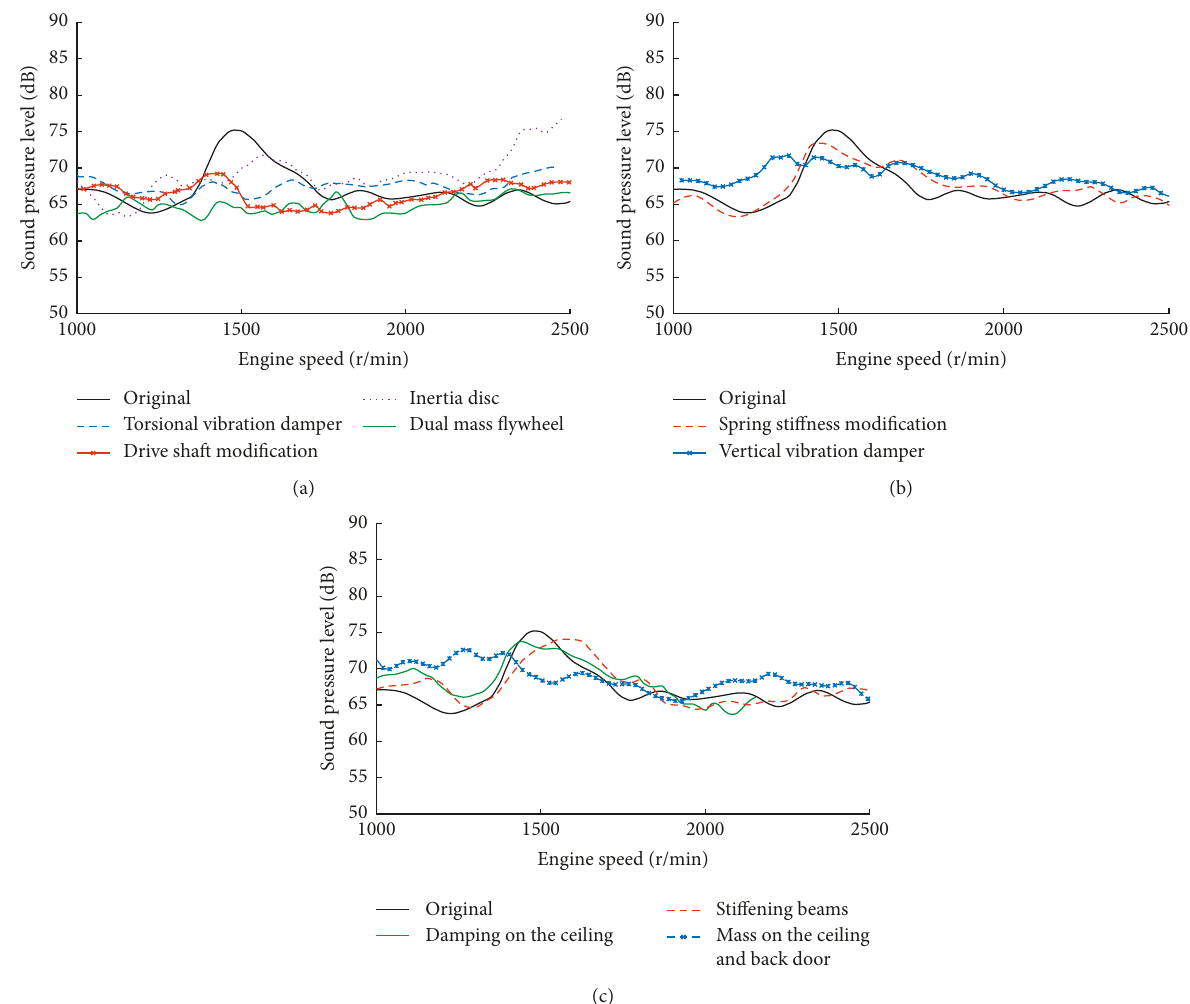
Figure 30: Internal noise experimental analysis of minivan with different modifications. (a) Driveline modifications. (b) Rear suspension modifications. (c) Vehicle body modifications.